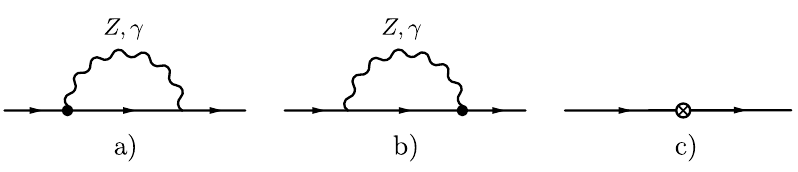
Figure 9 . One loop corrections due to 2 XH dipole operators on the fermion two point function. (6) operators is indicated with a black dot, and the counterterm matrix with The insertion of the L a